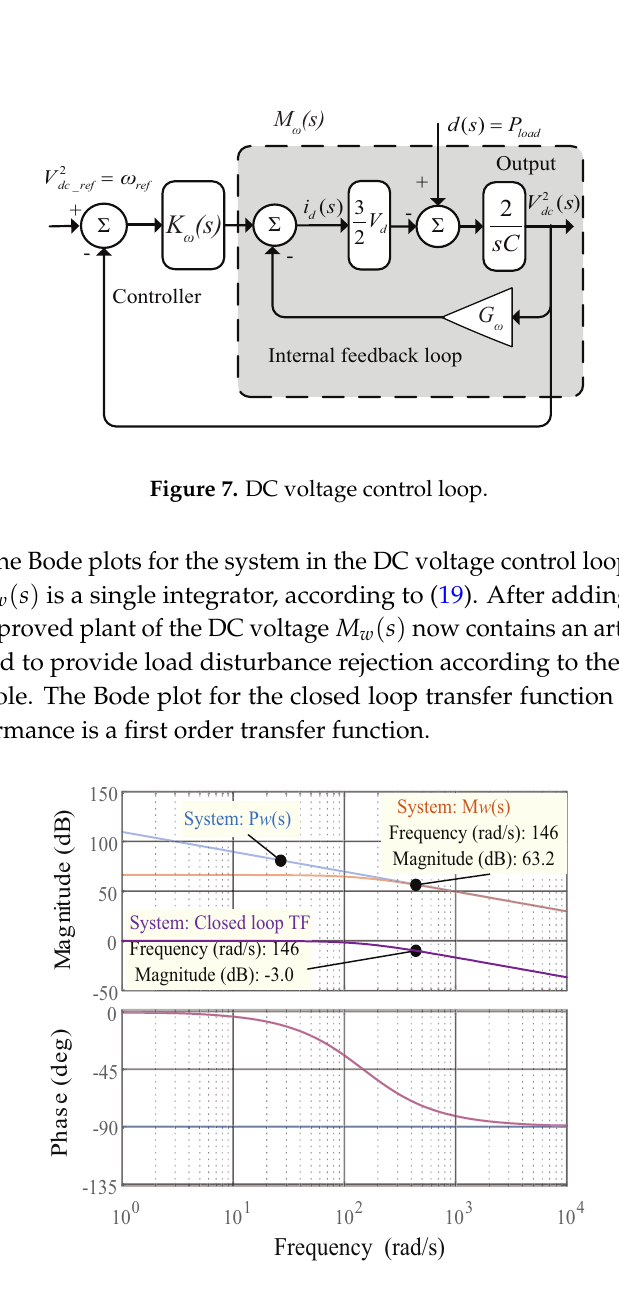
Figure 8. Bode diagram for the outer